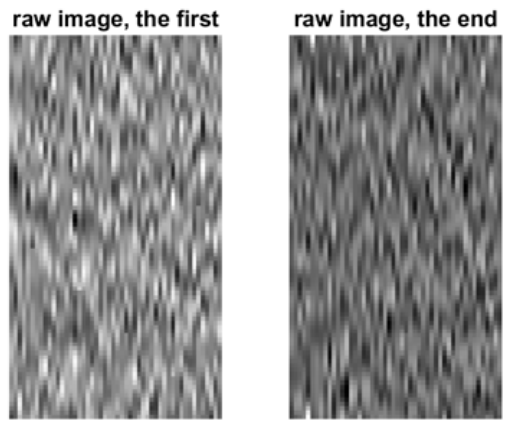
Figure 9. Primitive raw images for EEG data signal for the selected first and last trials (80 × 60) in